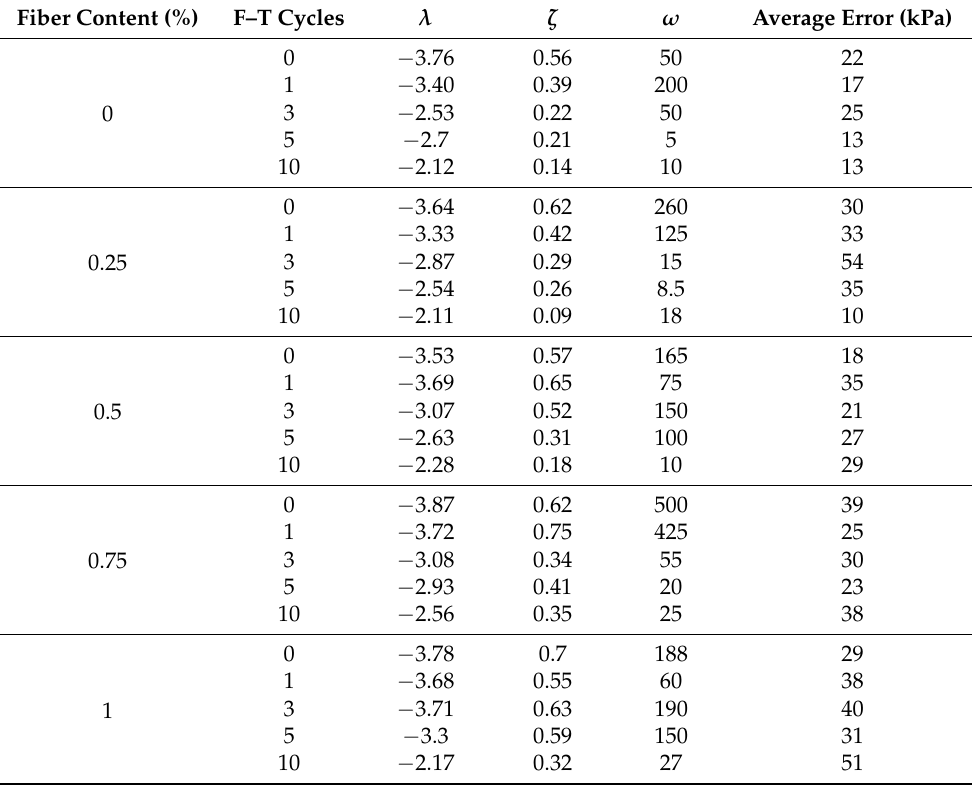
Table 4. Fitting table of F–T damage